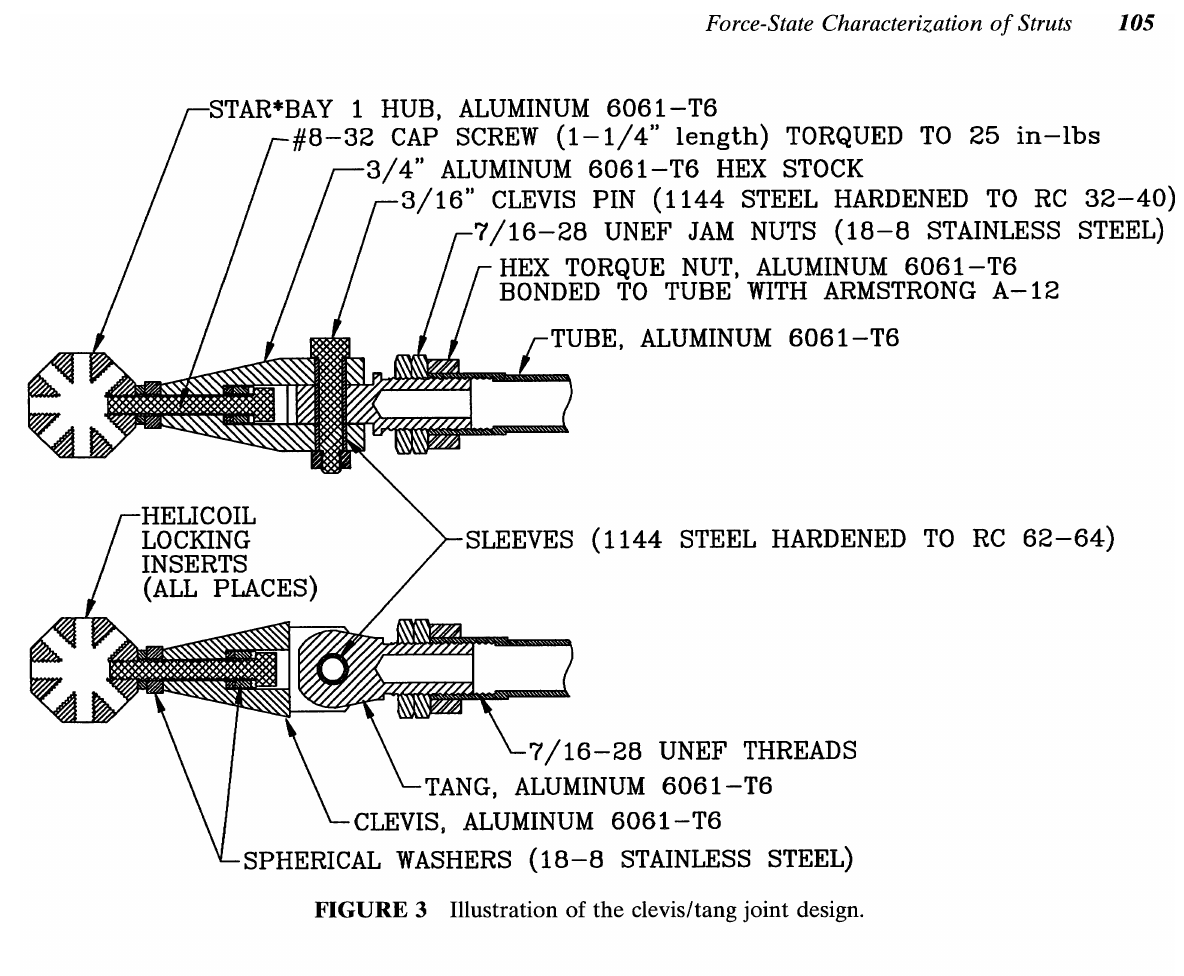
FIGURE 3 Illustration of the clevis/tang joint